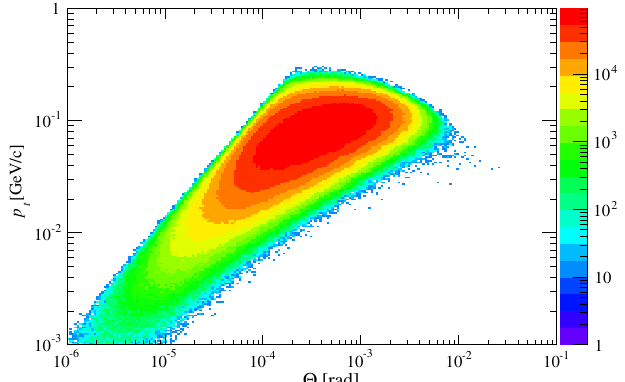
FIG. 3. Distribution of same-charge (defocused) coherent pairs after one bunch crossing using the 3 TeV CLIC baseline design parameters. On the z axis is the number of particles in each bin, per bunch crossing.